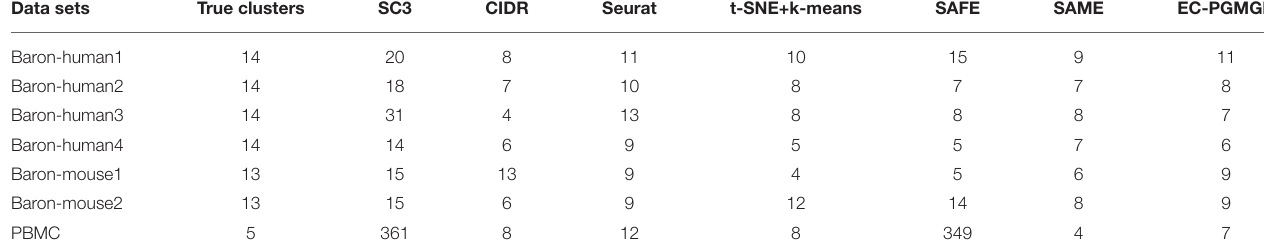
TABLE 2 | The number of clusters generated by different methods. Data sets